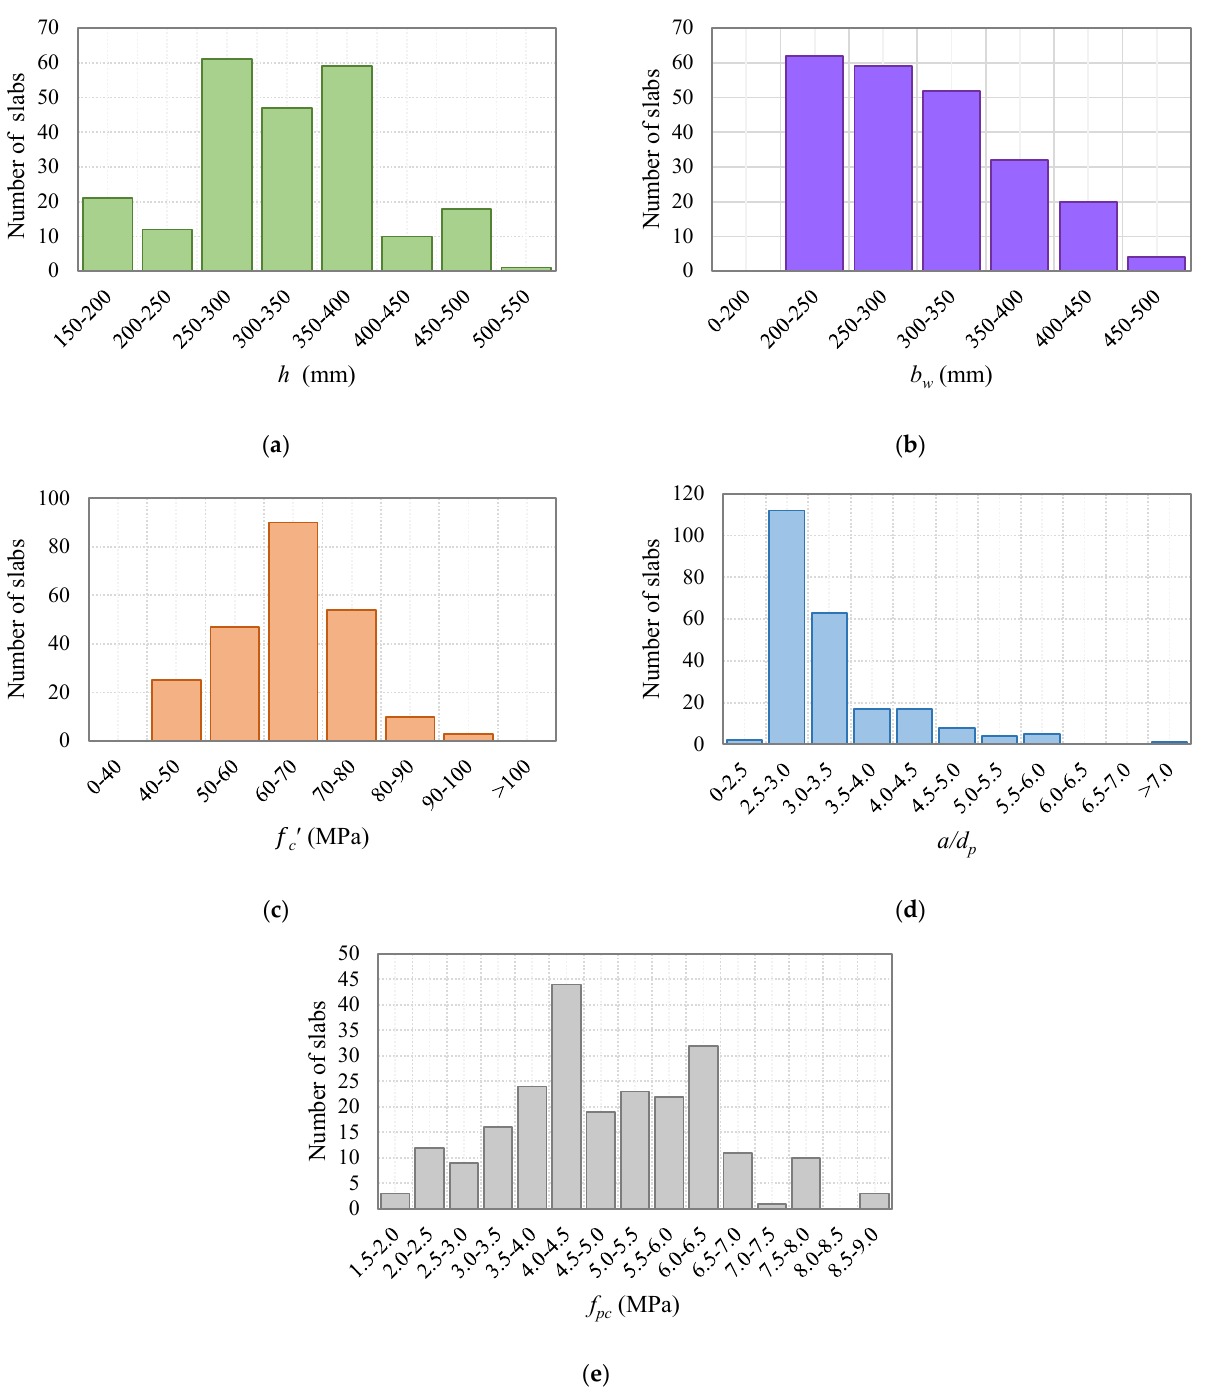
Figure 4. Ranges of design parameters of HCS. ( a ) Total thickness, ( b ) web width, ( c ) concrete compressive strength, ( d ) shear span to depth ratio, and ( e ) compressive stress due to full effective prestressing force. Table 1. Experimental database of prestressed HCS.